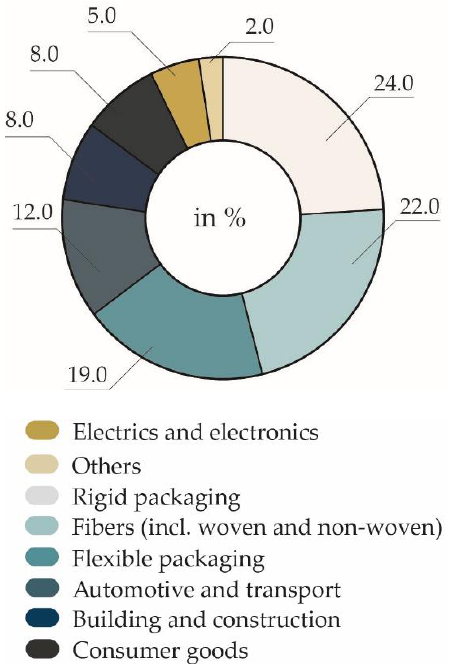
Figure 1. Use of bioplastics by market segment (2021). Reworked by the authors from